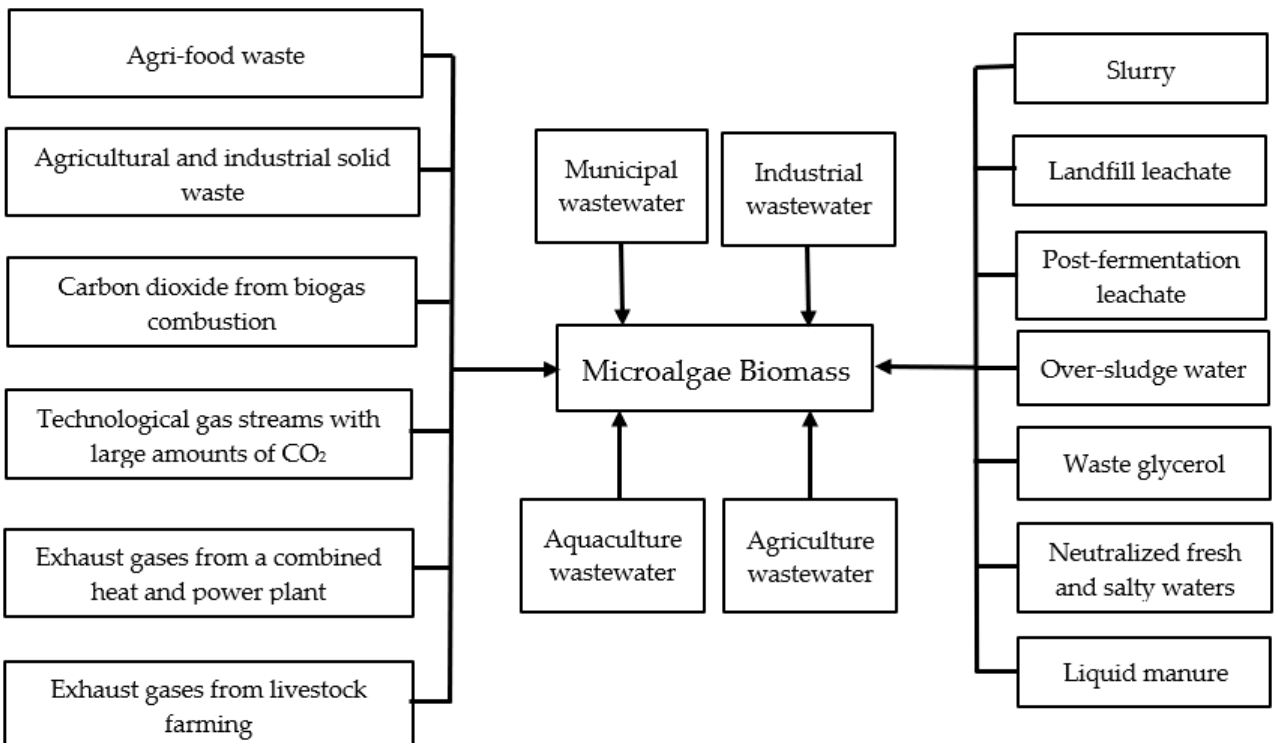
Figure 2. Primary types of waste used for microalgal biomass production.